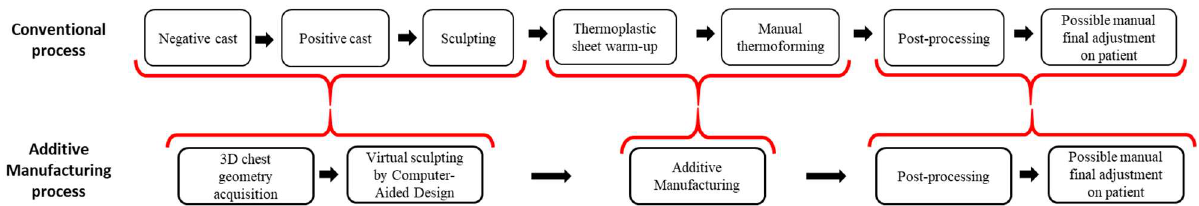
Figure 1. Conventional and additive manufacturing processes for braces.